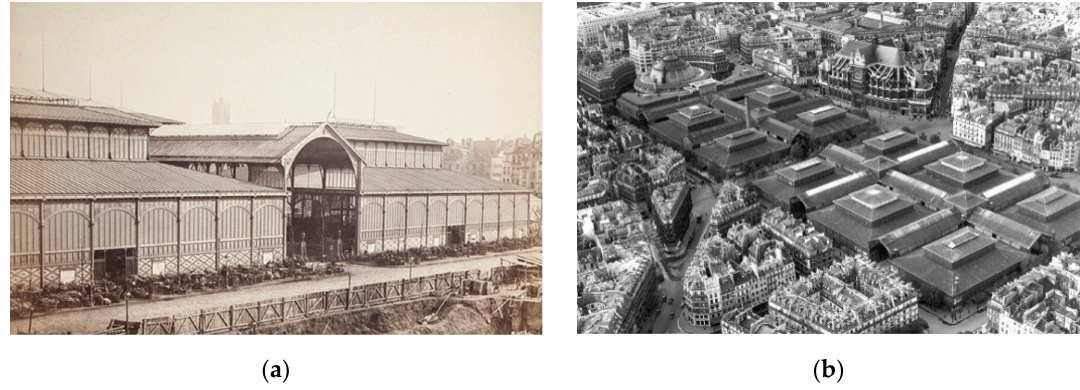
Figure 4. The pavilions of Les Halles. ( a ) Les Halles in a historical photograph by Melville; and ( b ) from a top view.